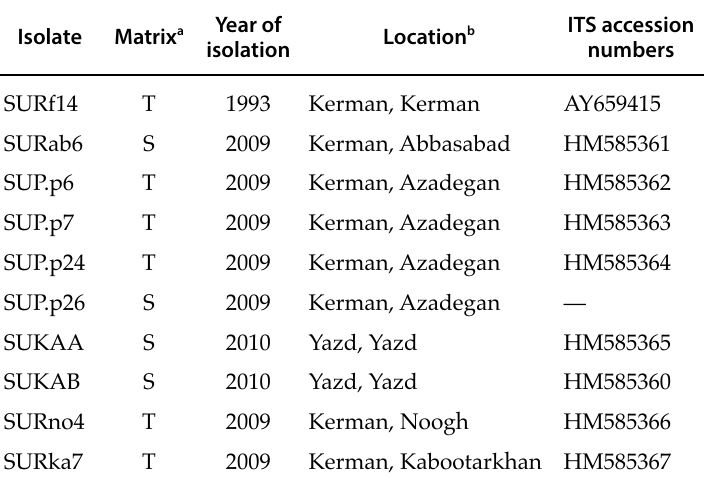
Table 1. Isolates of Phytophthora pistaciae recovered from infected tissues of pistachio trees or infested soil around the trees in different parts of the Iran, and their ITS accession numbers from the GenBank